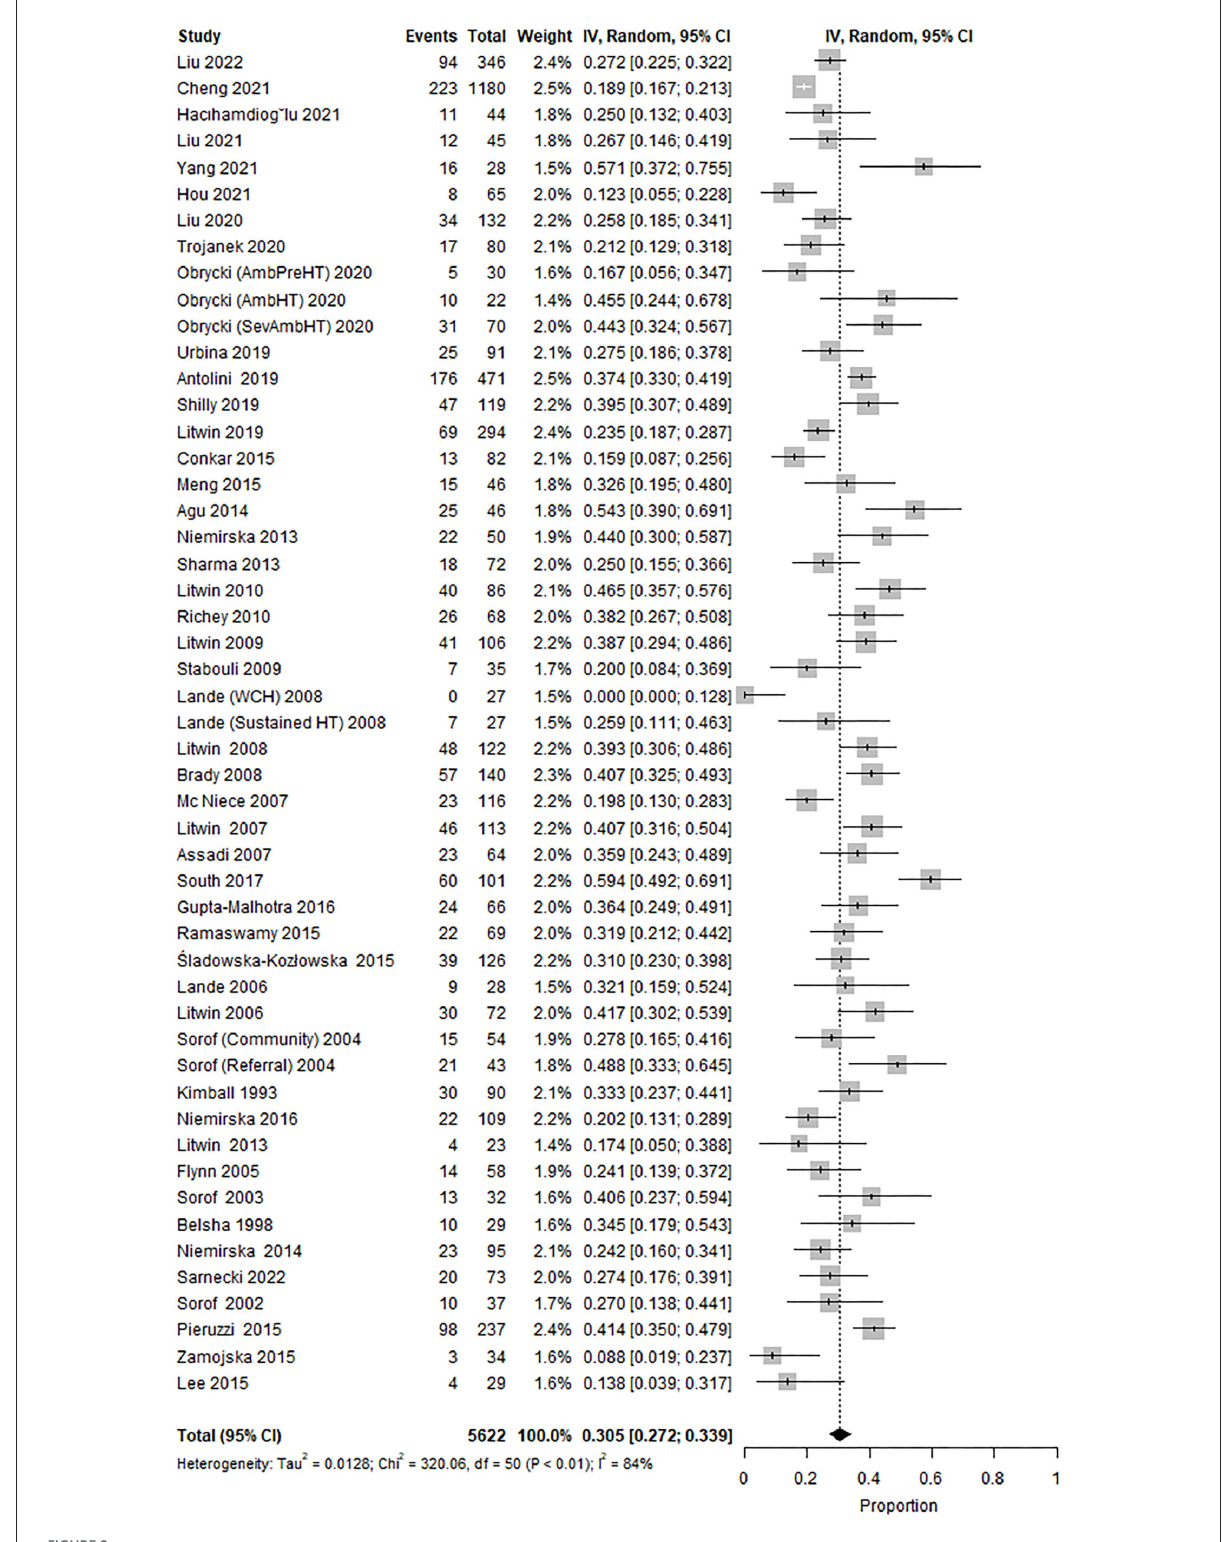
FIGURE2 Forest plot showing the prevalence of LVH in all identified studies (47 studies, 51 study